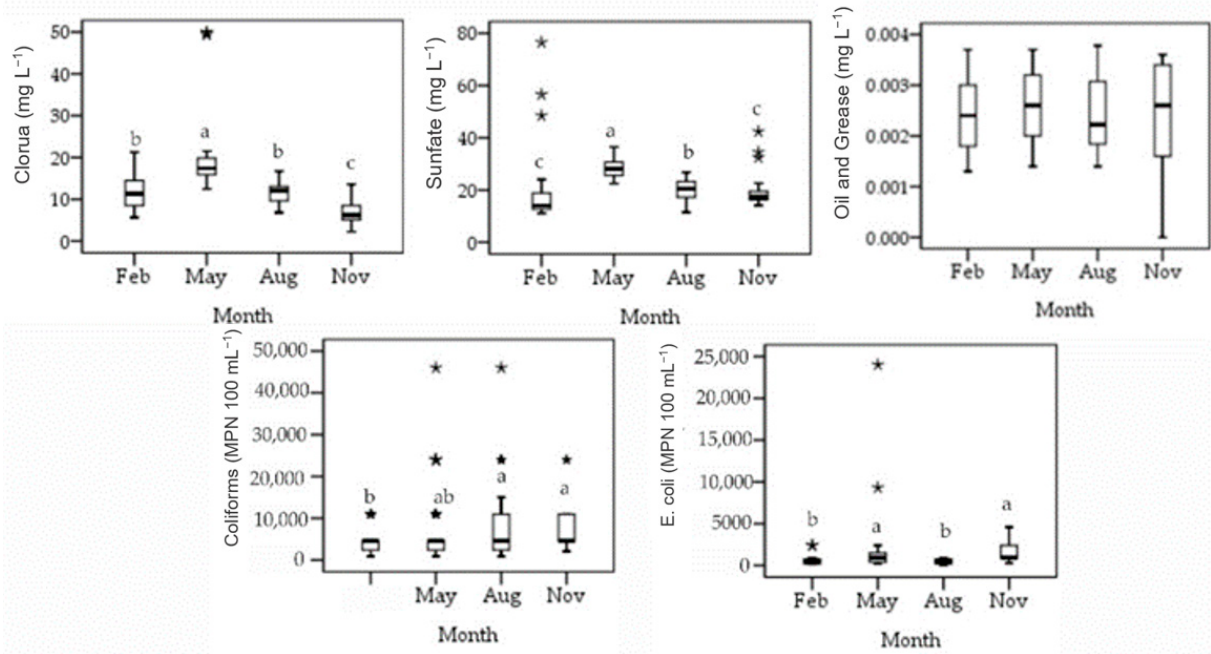
Figure 4. Microbial and ions variables of water in Dong Thap province in 2019. Note: * the highest/lowest values of variation; Letters a, b, c indicated significant differences at a significance level of 5%; in contrast, the same letters have no statistically significant difference.